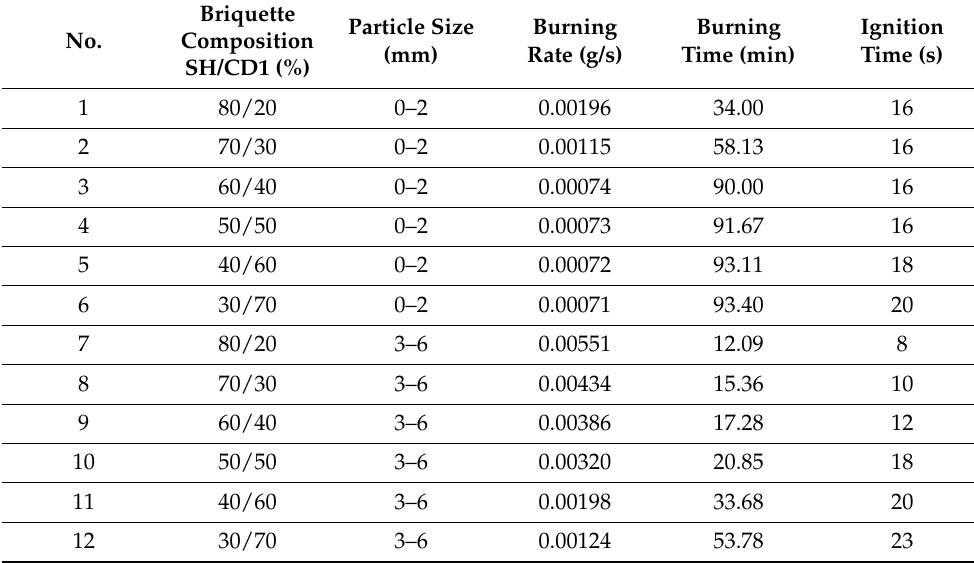
Table 3. The results of burning rate, burning time, and ignition (sunflower husk and Karazhyra